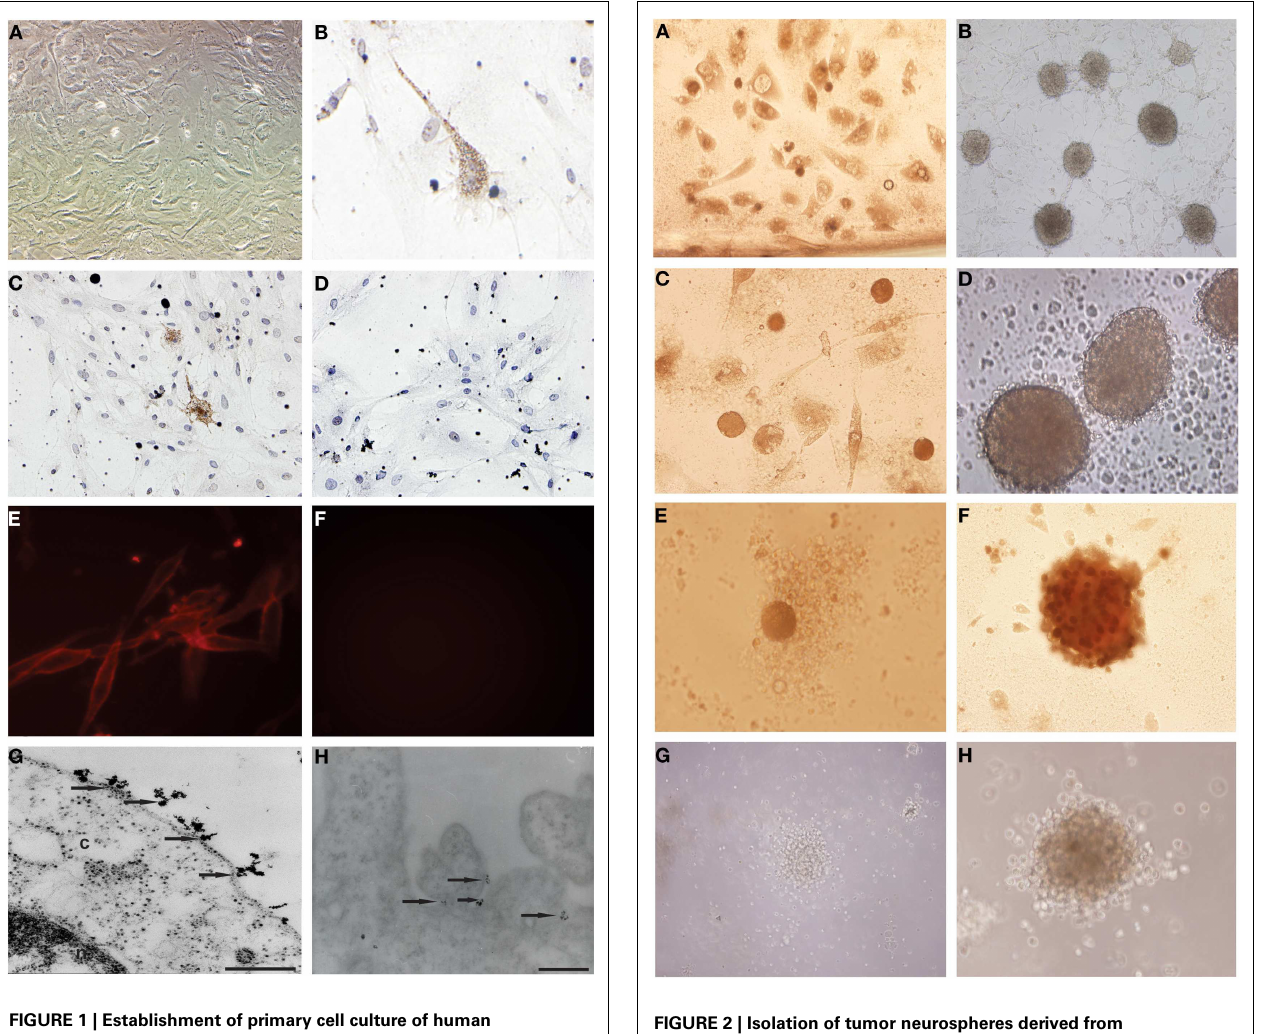
(TEM) (18). The cells were fixed in 1% glutaraldehyde and 0.2 M